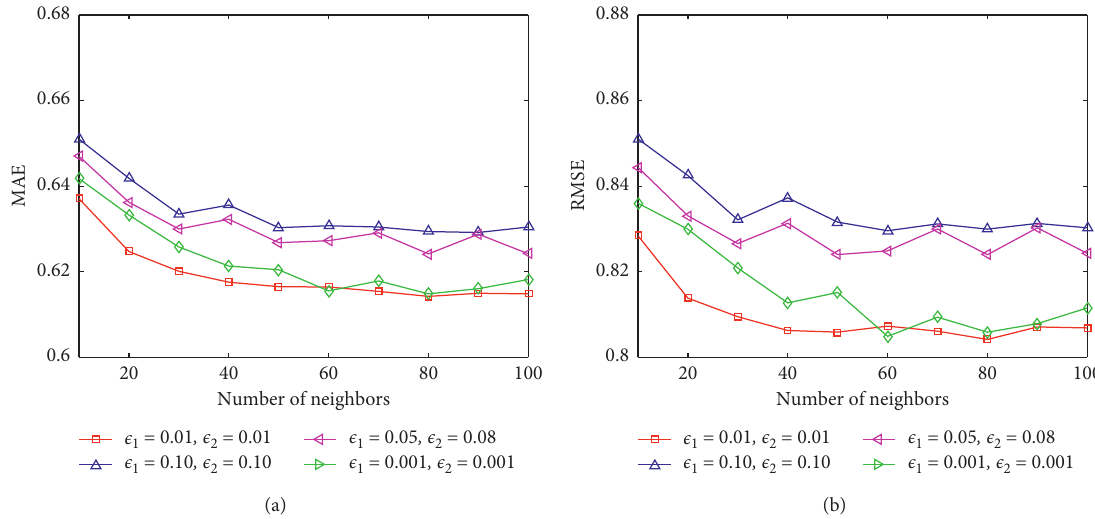
Figure 6: Filmtrust-1. (a) MAE results between different values of ε